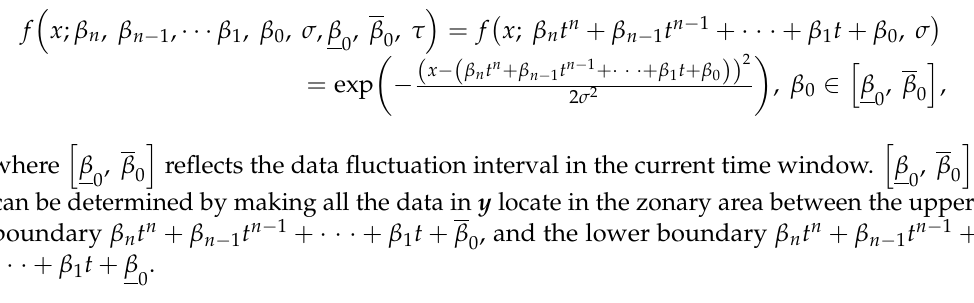
Figure 3. A linear fuzzy information granule.